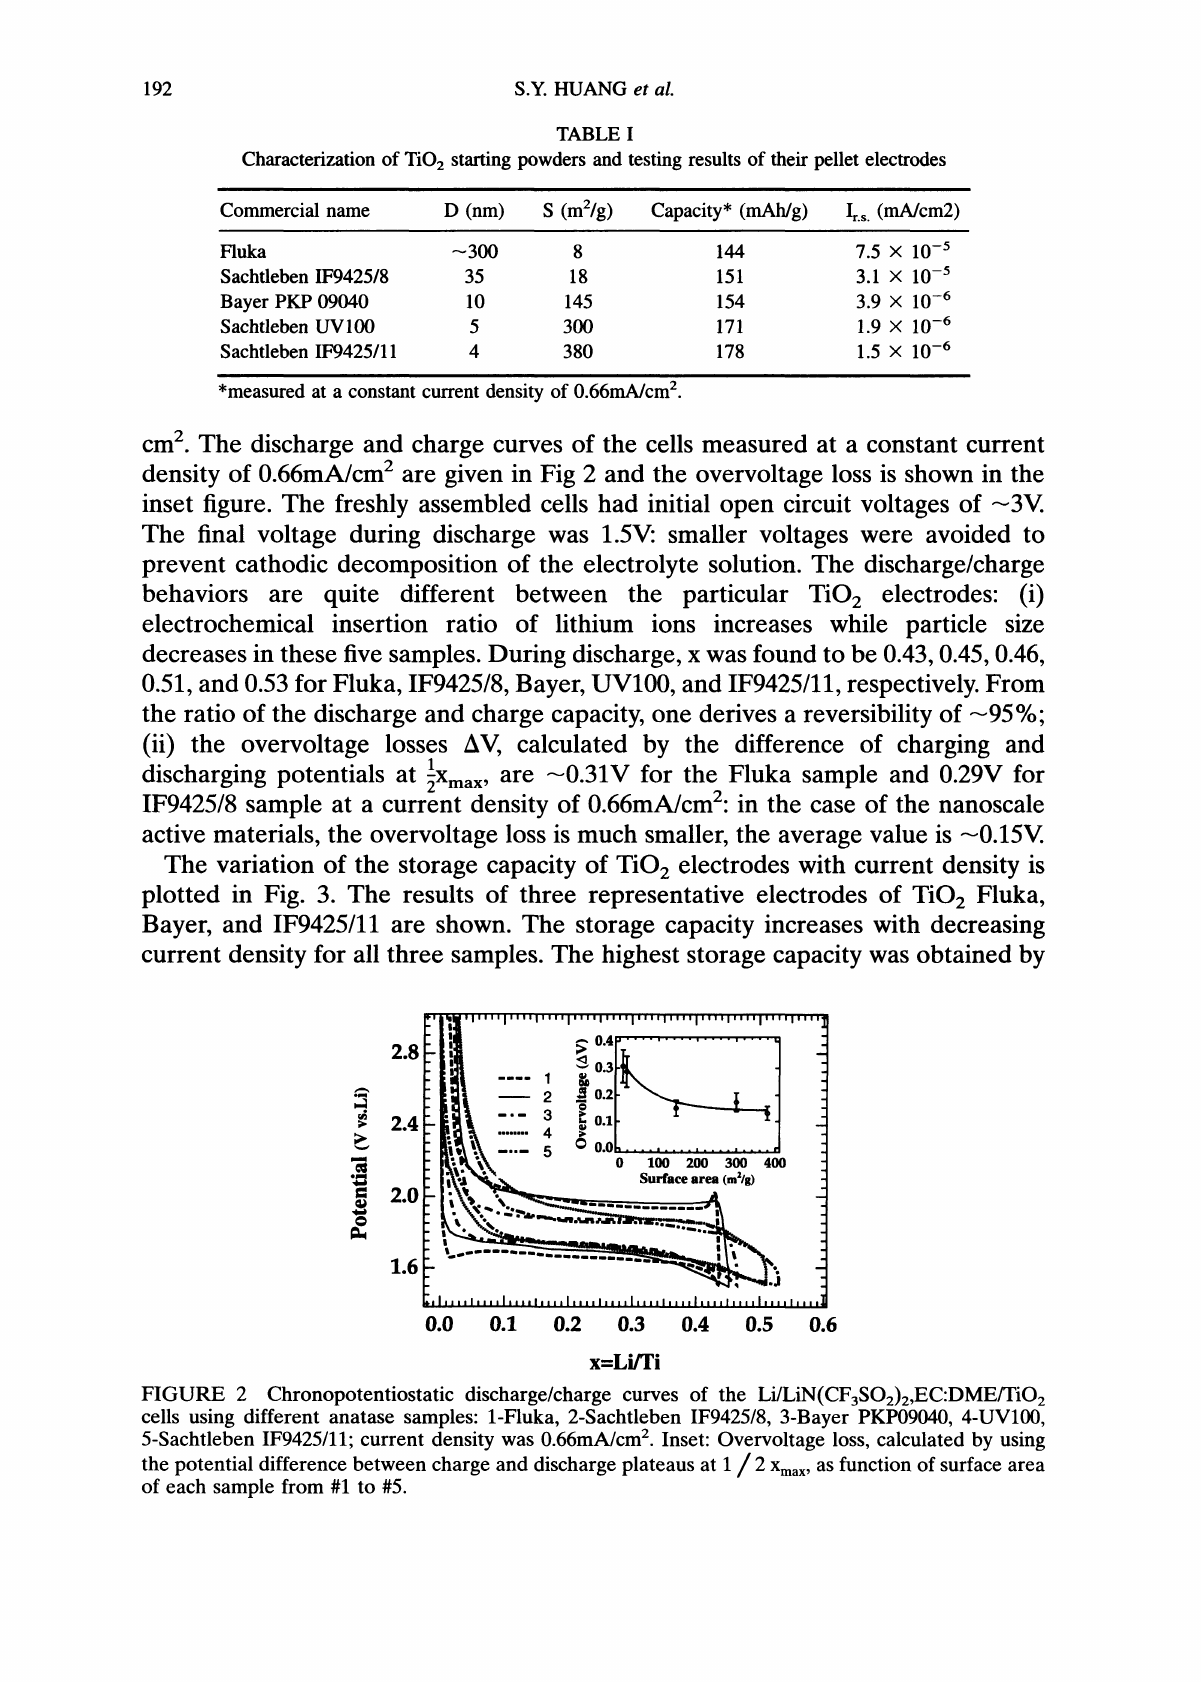
FIGURE 2 Chronopotentiostatic discharge/charge cues of the Li/LiN(CF3SO2)2,EC:DMEffiO2 cells using different anatase samples: 1-Fluka, 2-Sachtleben IF9425/8, 3-Bayer PKP090,